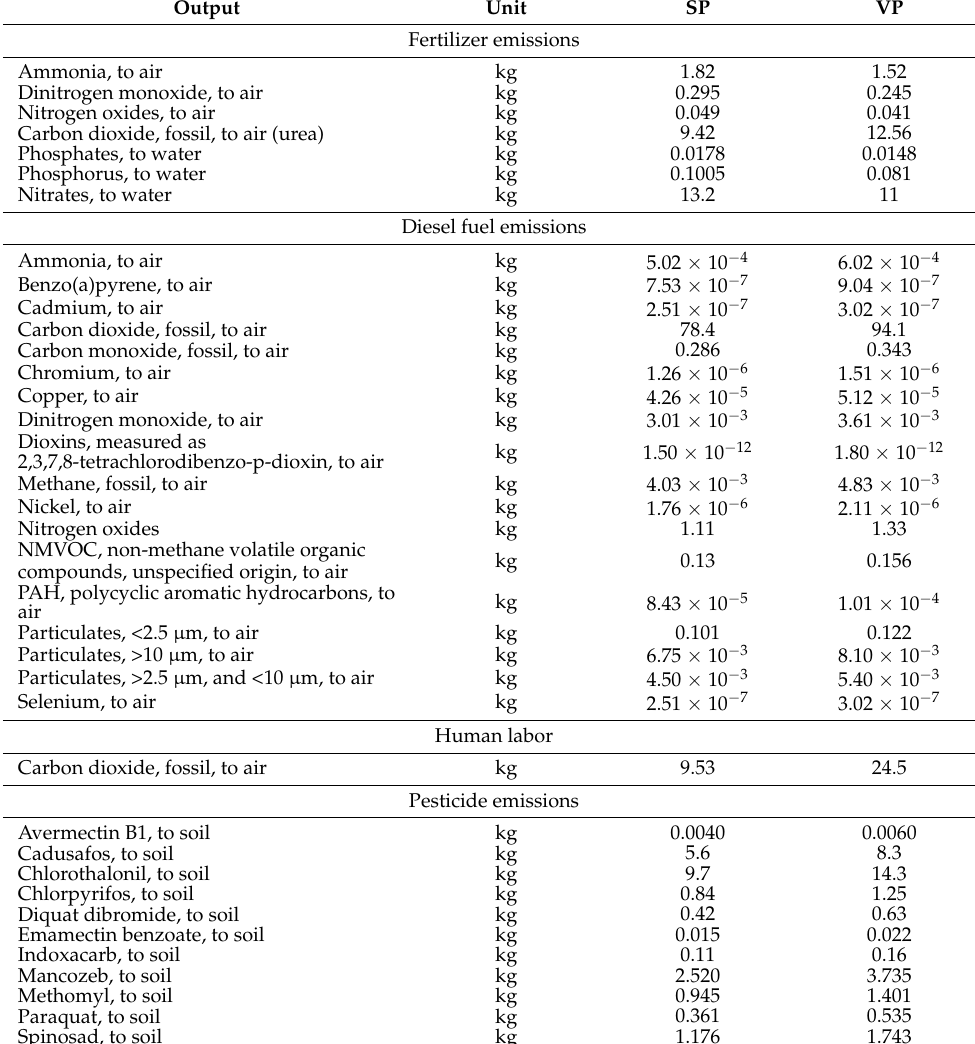
Table 3. On-farm (foreground) emissions for 1 ton of seed propagated (SP) and vegetative propagated (VP) globe artichoke heads at the farm exit